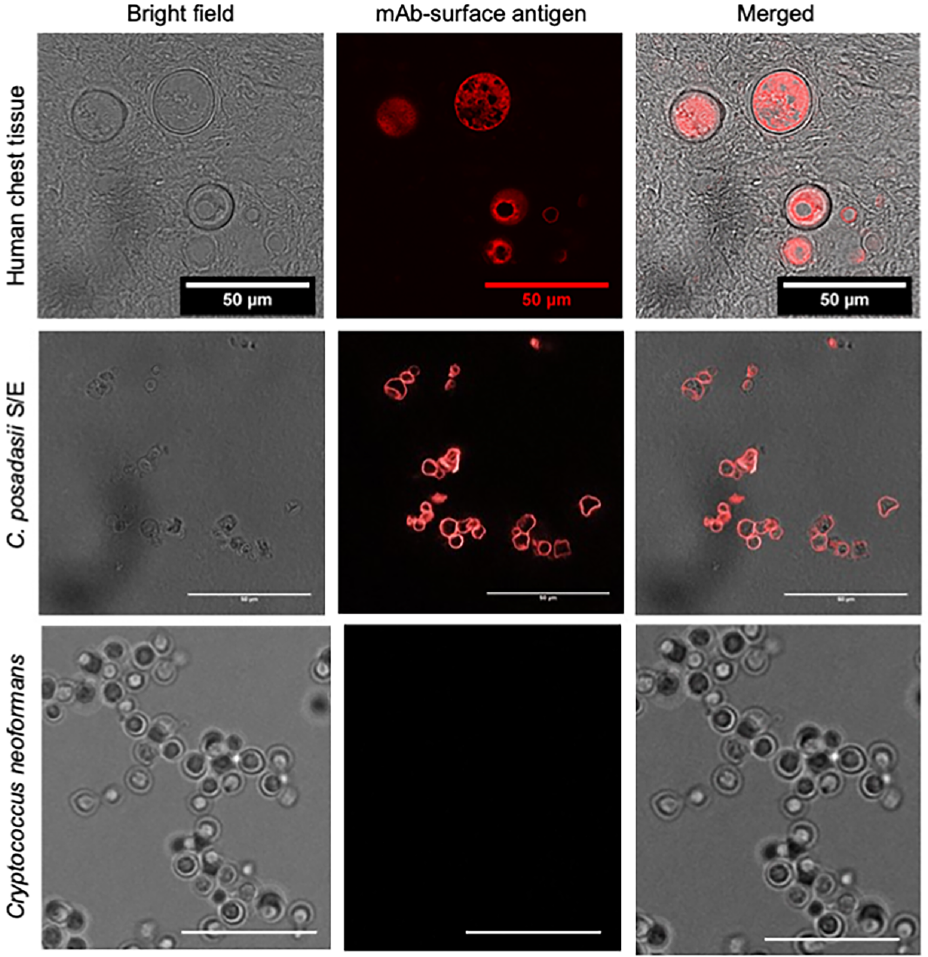
Figure 2. Surface antigen of C. posadasii S/E strain similar to Coccidioides identified in human chest tissue . ( Top panel): IHC staining with a Coccidioides surface antigen mAb detects spherules in human chest tissue with confirmed coccidioidomycosis. Coccidioides spherules were identified by brightfield imaging 10–30 µm. IHC staining using the Coccidioides mAb primary antibody and Alexa Fluor ® 568 secondary antibody showed specific fluorescent signal localized on the surface of spher- ules (100× magnification). Brightfield and fluorescence images were merged and showed co-locali- zation of spherules and fluorescent signal. ( Middle panel): the same primary mAb used above stained the surface of C. posadasii S/E stain fixed with thimerosal. Coccidioides mAb primary antibody and Alexa Fluor ® 568 secondary antibody showed specific fluorescent signal localized on the surface of spherules. ( Bottom panel): Coccidioides -specific mAb did not cross react with the Cryptococcus neoformans KN99 reference strain (100× magnification, scale bar 25 µm). We further examined the surface antigens of C. posadasii S/E spherules by identifying surface-exposed proteins. We isolated four highly abundant extracellular proteins by uti- lizing trypsin shaving of intact spherules from the cultured C. posadasii S/E strain and mass spectrometry for protein identification. Copper-zinc superoxide dismutase (SOD), DO- MON-like type 9 carbohydrate binding module, aspartyl protease, and mannosyl-oligo- saccharide alpha-1,2-mannosidase precursor were identified as surface proteins of C. po- sadasii S/E spherules (Table 1, Supplementary File S1). These same proteins were identified as immunoreactive antigens in other Coccidioides strains from previous studies [15–19].